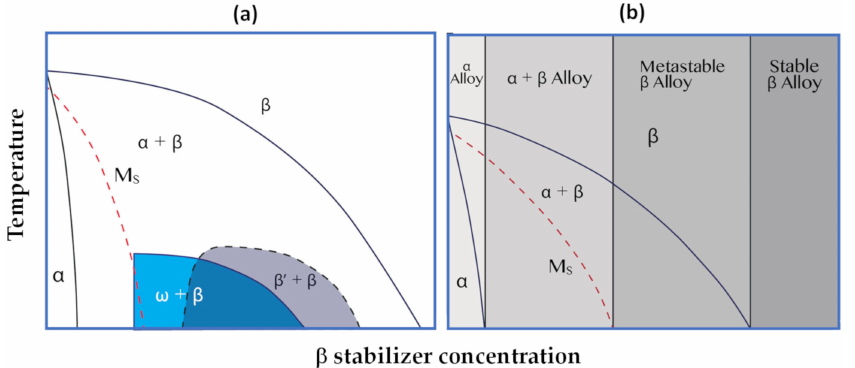
Figure 1. ( a ) Classification of Ti alloy as a function of β stabilizer concentration. ( b ) Scheme of metastable ( ω + β ) and ( β (cid:48) + β ) phase field